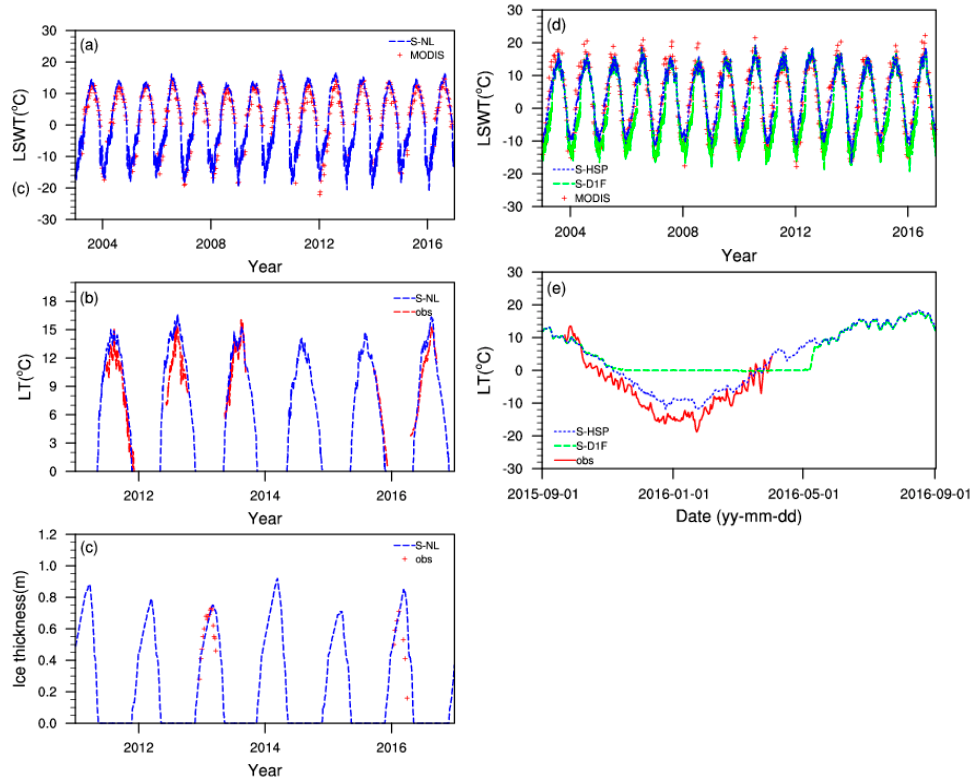
Figure 3. Observed and simulated LSWT ( a ), LT ( b ) and ice thickness ( c ) in S-NL, and LSWT ( d ) and LT ( e ) in S-HSP and LT ( e ) in S-HSP and S-D1F.